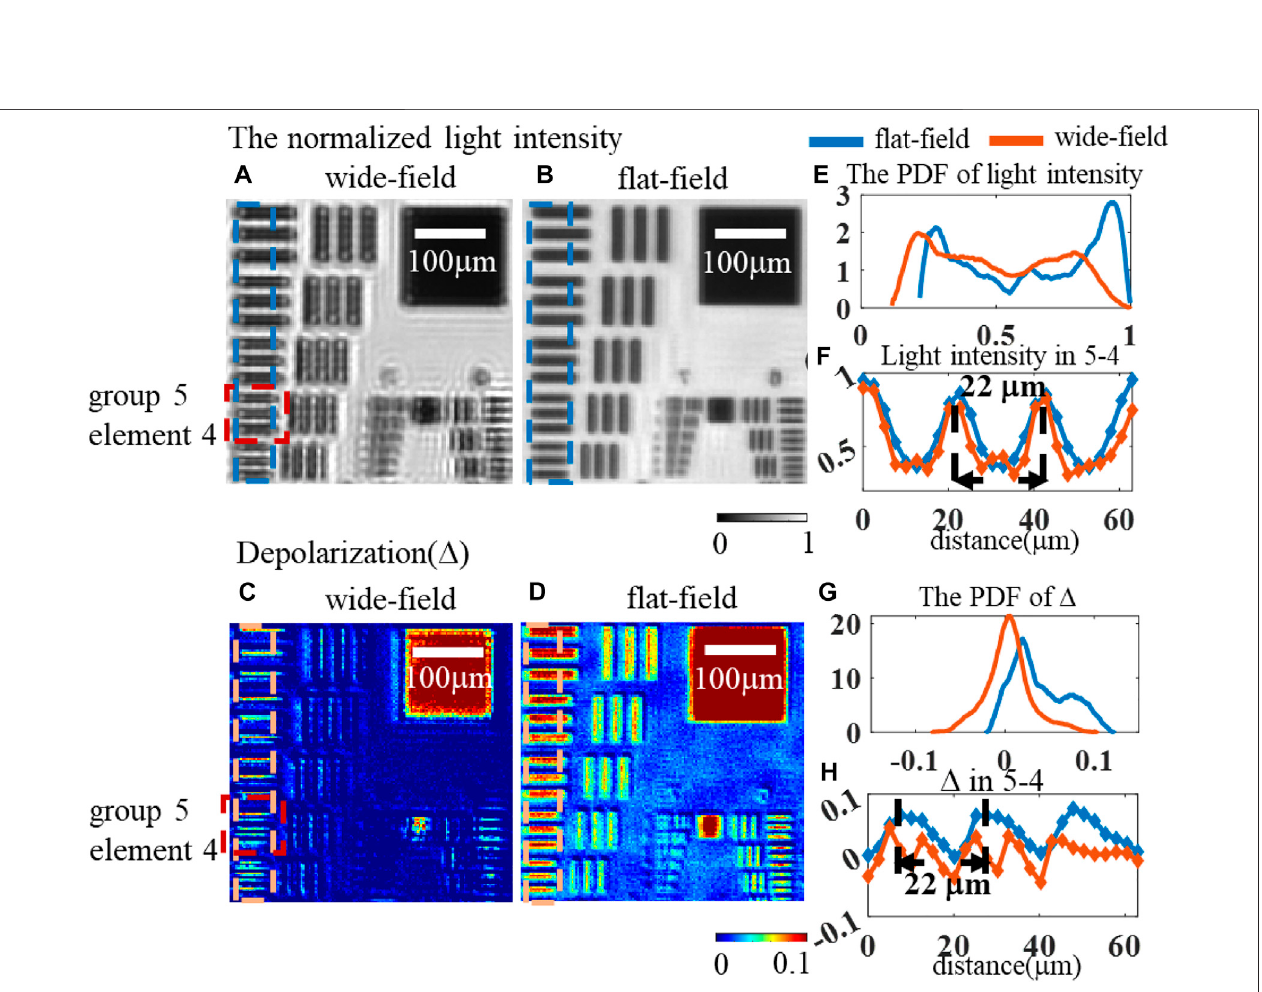
Frontiers in Physics |